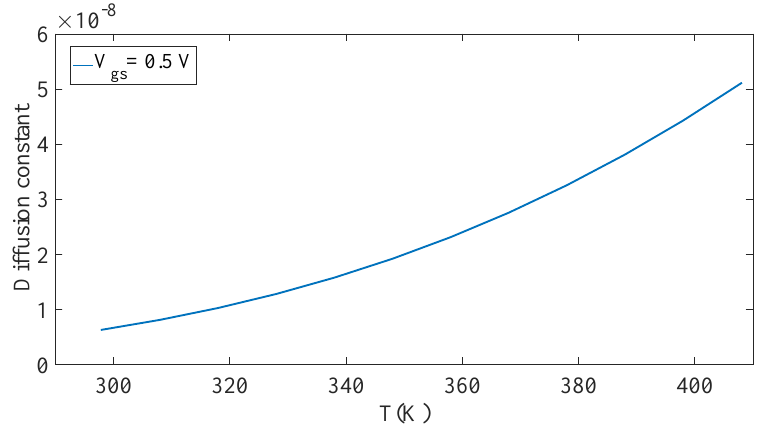
Figure 10. Diffusion constant for InGaAs − − Al 2 O 3 interface with varying temperatures.